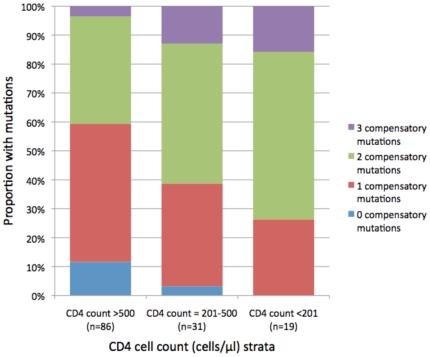
Prevalence of compensatory mutations with the T242N mutation in the
HLA-B57 and B*5801 restricted epitope, Gag TW10.In the 100% stacked column, the y-axis shows the number of
mutations accumulated at the three Gag protein amino acid sites (H219Q,
I223V and M228I) that compensate for the T242N mutation [27].
The x-axis depicts the categorical CD4 T cell count strata and the
number of patients within each strata (the “High CD4” group
refers to patients with CD4 T cell counts >500 cells/µl, the
“Intermediate CD4” group refers to patients with CD4 T cell
counts between 200 and 400 cells/µl, and the “Low CD4”
group refers to patients with CD4 T cell counts <100
cells/µl).